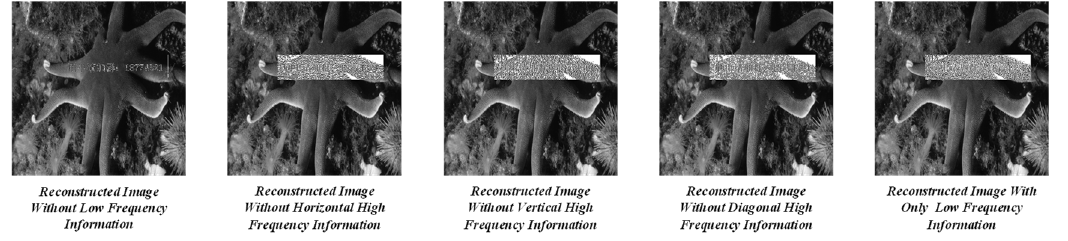
Figure 4. Reconstructed images lacking different frequency domain information.